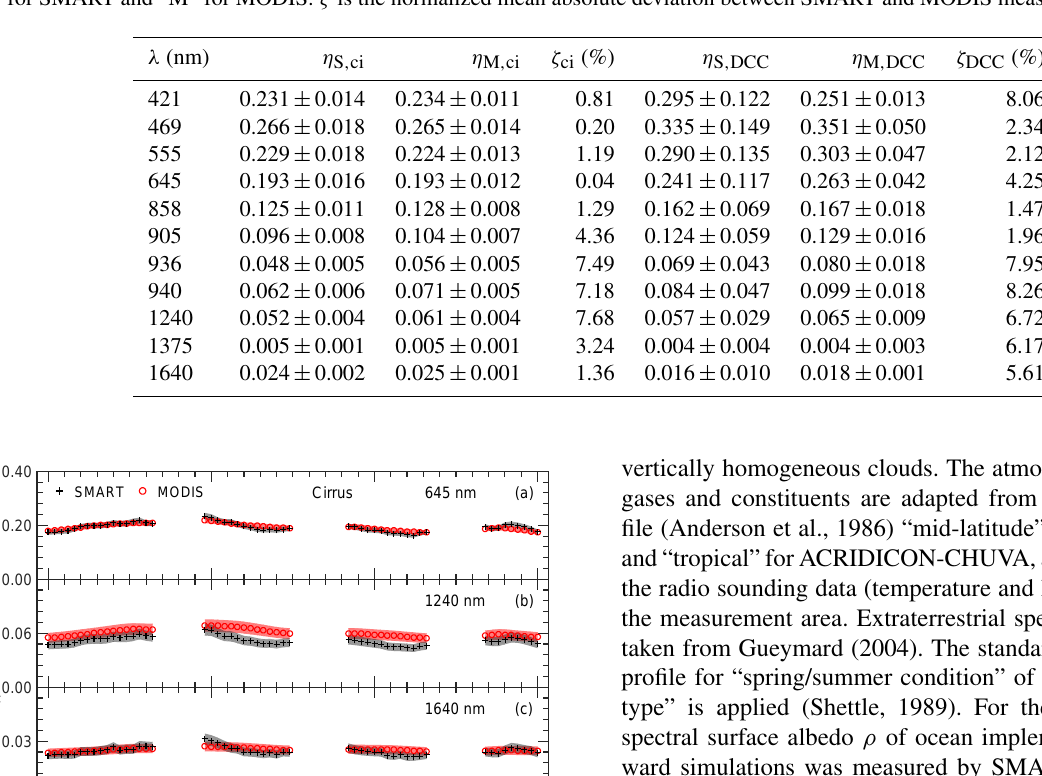
Figure 3. MODIS radiance band 1 ( λ = 645nm) for the cirrus case (a) and the DCC case (b) superimposed with the selected flight legs of HALO during cloud measurements (red line). The flight direction is from point A to B. ↑ ↑ Table 2. Comparison of SMART I and MODIS I for the cirrus (ci) and DCC case. η is the mean standard deviation with the subscripts M ,λ S ,λ “S” for SMART and “M” for MODIS. ζ is the normalized mean absolute deviation between SMART and MODIS measurements.